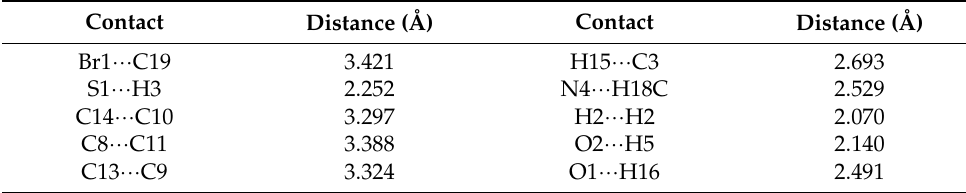
Table 4. Most important contacts and the corresponding shortest interaction distances.